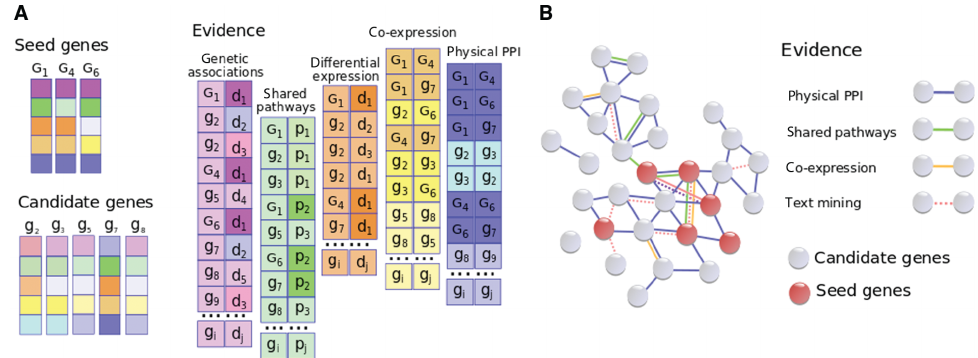
Figure 2: Data representation models utilized by gene prioritization tools. A. Relational data structure. The first and the third evidence sources provide relationships between genes labeled with G (seeds) or g (candidates) and diseases ( d ), the second source provides gene membership in pathways ( p ) and the last two evidence sources contain different kinds of interactions between genes. Vector representation of seed and candidate genes are shown on the left. The similarity be- tween colorings of gene g and seed genes shows that g seems to be a promising candidate. B. Network data structure. 7 7 Nodes depict genes, edges show relationships between genes. Seed genes are highlighted with red. Types of interactions and associations are shown on the